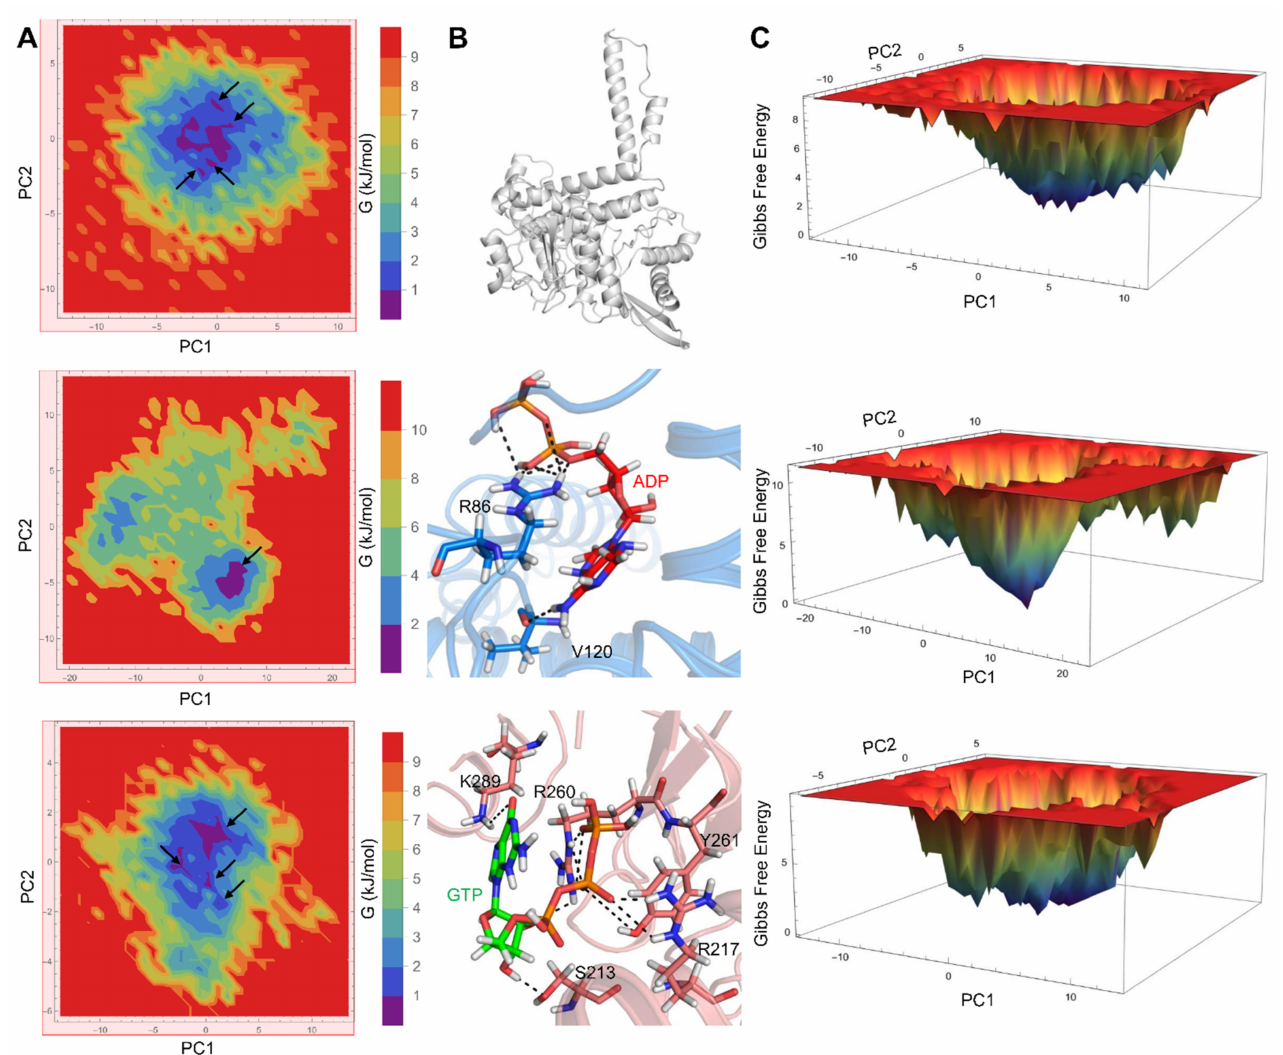
Figure 4. Free energy landscape (FEL) contour plots of GDH states. ( A ) Two-dimensional FELs of apo (top panel), agonist- bound (middle panel), and antagonist-bound (bottom panel) GDH states, shown as a function of two PCs that were selected based on a cosine content value ≤ 0.2. The minimal energy clusters in all three GDH states are shown by black arrows. ( B ) The minimal energy structures of apo, ADP-bound, and GTP-bound GDH states are shown. Residues critical for ligand recognition are depicted as blue and salmon-colored sticks and H-bonds are shown as black dashed lines. ( C ) Three-dimensional FEL plots of apo (top panel), agonist-bound (middle panel), and antagonist-bound (bottom panel) GDH